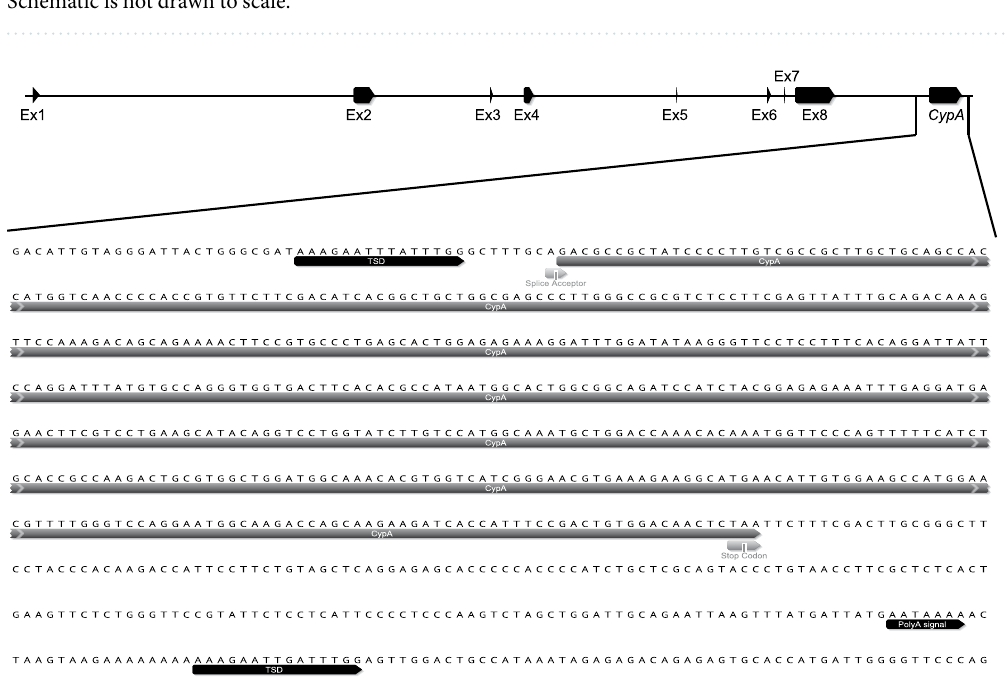
Figure 4. Schematic of the genomic organization of TrimCyp genes identified in mammals. Gray regions indicate the 5 ′ and 3 ′ untranslated regions. Black boxes indicate CDS. CypA insertions are shown in red. Schematic is not drawn to scale.